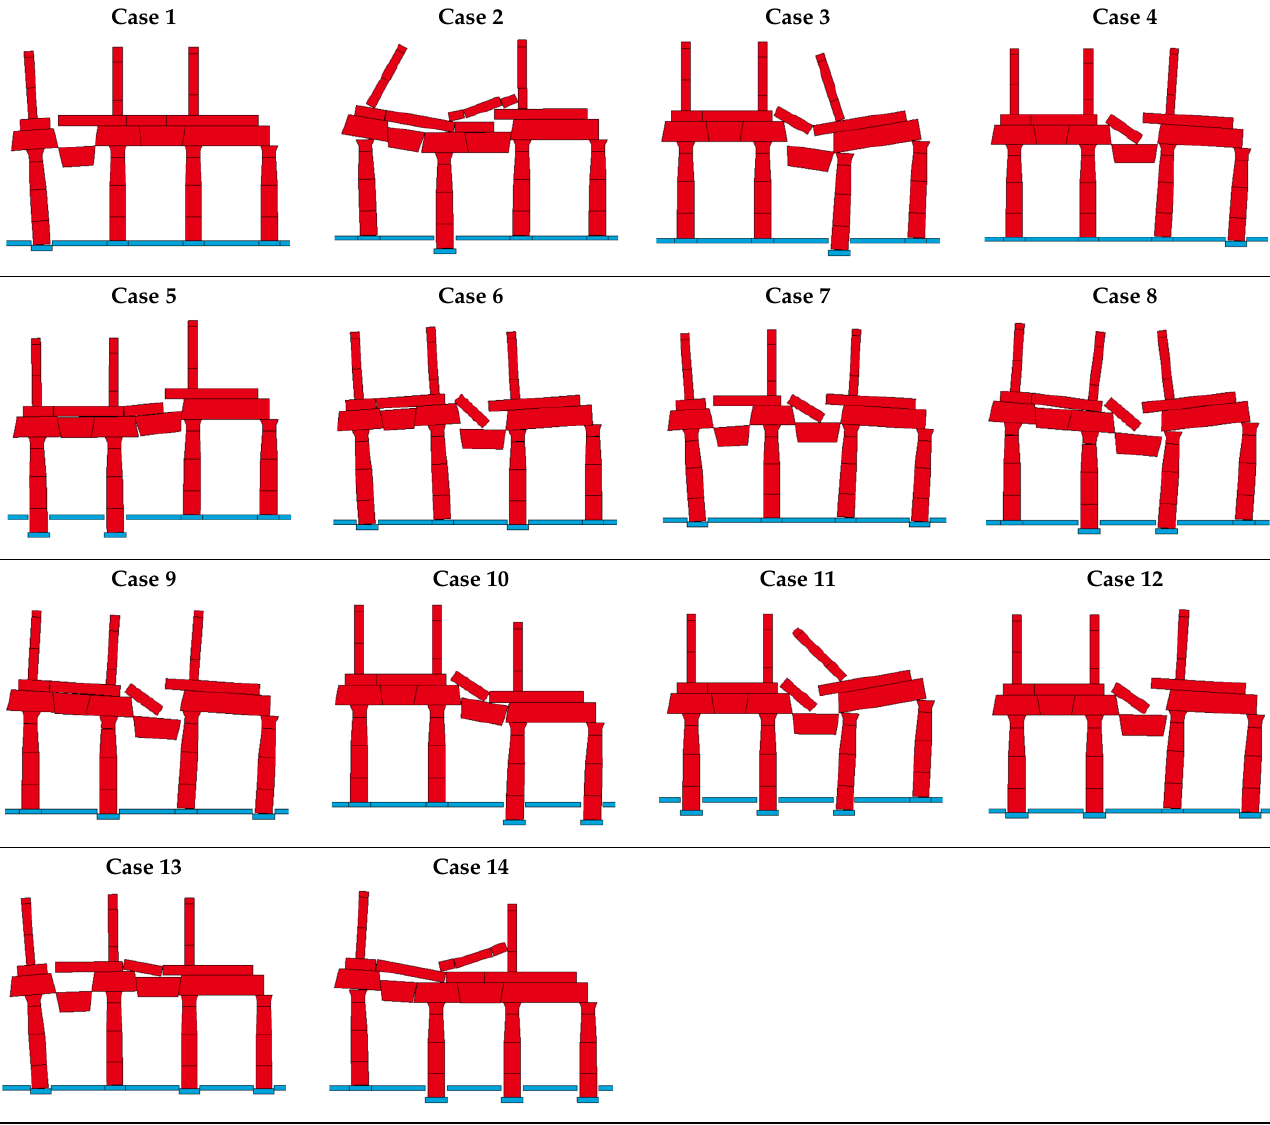
Table 2. Material properties of the colonnade.